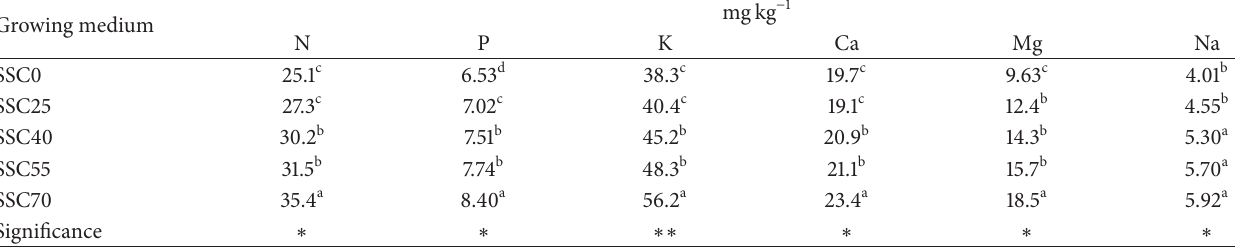
Table 9: Concentrations of macronutrients in tissues of Bougainvillea plants as influenced by growing media (150DAT, on dry matter basis). Growing medium